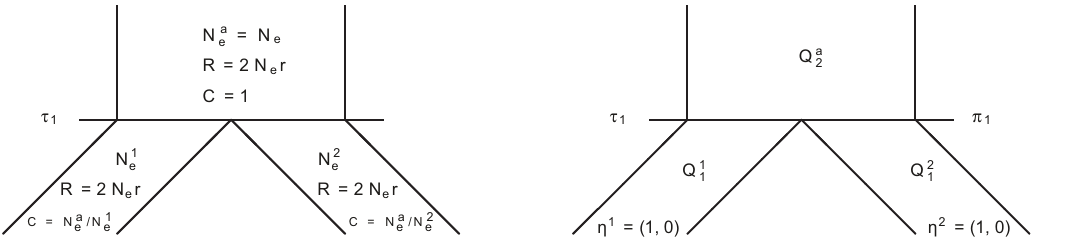
Figure 14. Isolation model. Left: Parameters of the model; we use the ancestral population as the reference population. Right: Rate matrices for the single sequence systems and (ancestral) two-sequence